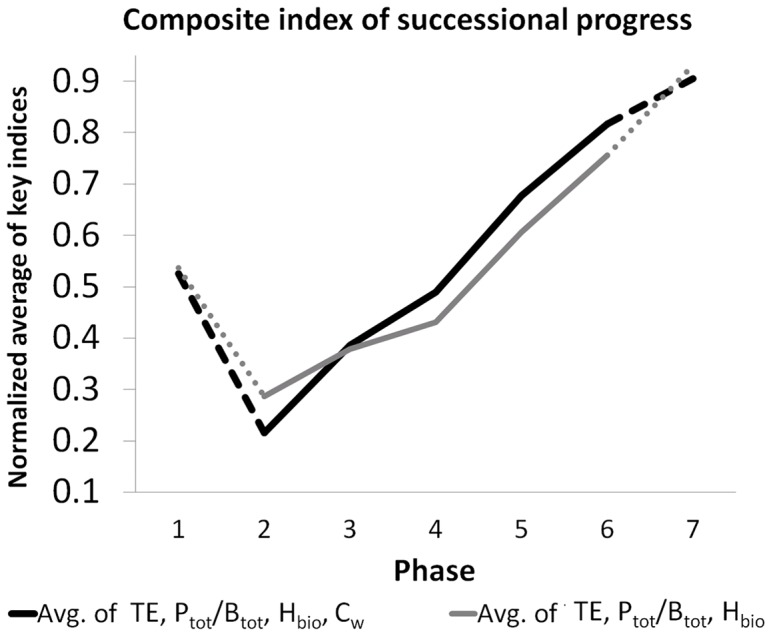
Composite index of successional progress.The composite index based on the average of the four normalized indices TE, Ptot/Btot, Hbio, and Cw (black line) increases approximately linearly during the growing season from phase 2–6. The result is similar if Cw is excluded from the calculation (gray line). Higher values during the winter phases (dashed/dotted part of the lines) are caused by the very low Ptot/Btot values which are due to the influence of abiotic forcing rather than biotic processes.